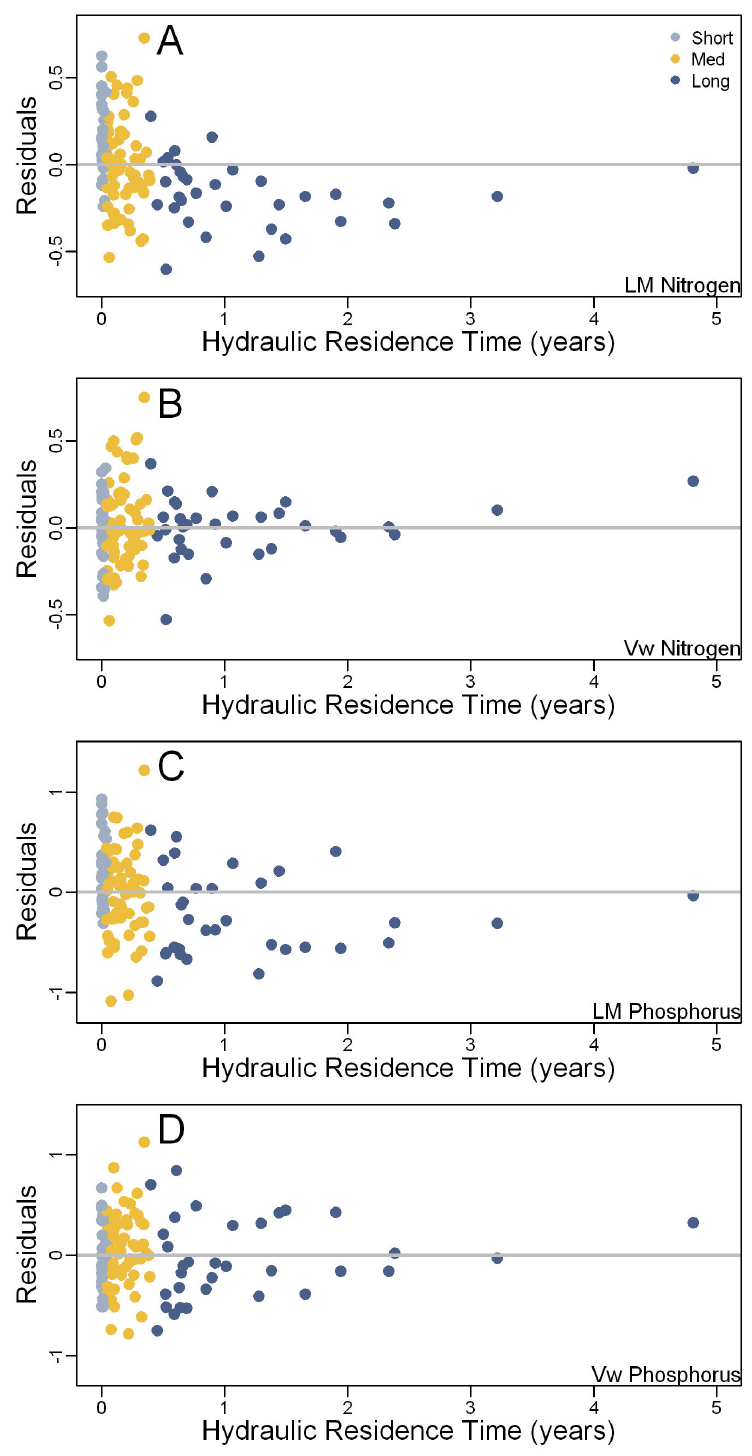
Figure 6. Plot of model residuals by hydraulic residence time. Panels: (A) linear model (LM) for total nitrogen; (B) Vollenweider (Vw) model for total nitrogen; (C) linear model (LM) for total phosphorus; and, (D) Vollenweider (Vw) model for total phosphorus. For both nutrients, the linear models (A and C) show a bias towards negative residuals (overestimation) for longer residence times. In contrast, the residuals for the Vollenweider models (B and D) are independent of residence time. Observations are color coded by hydraulic residence time (Short: < 0.04 years; Medium: 0.04 to 0.4 years; Long: > 0.4 years). doi: 10.1371/journal.pone.0081457.g006 PLOS ONE |